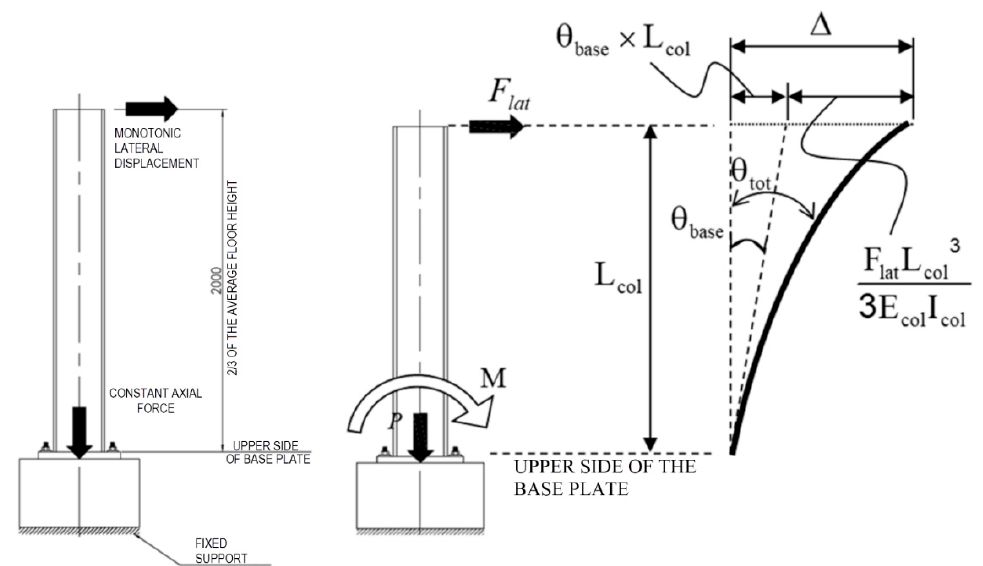
Figure 4. Loading protocol and response parameters.